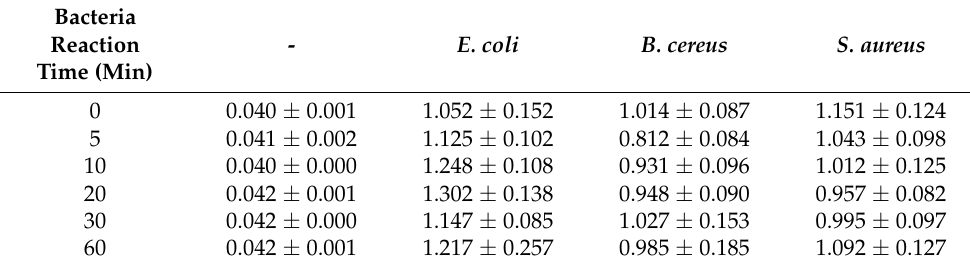
Table 4. Analysis of the antimicrobial activity of iTME under proteolytic enzymes.